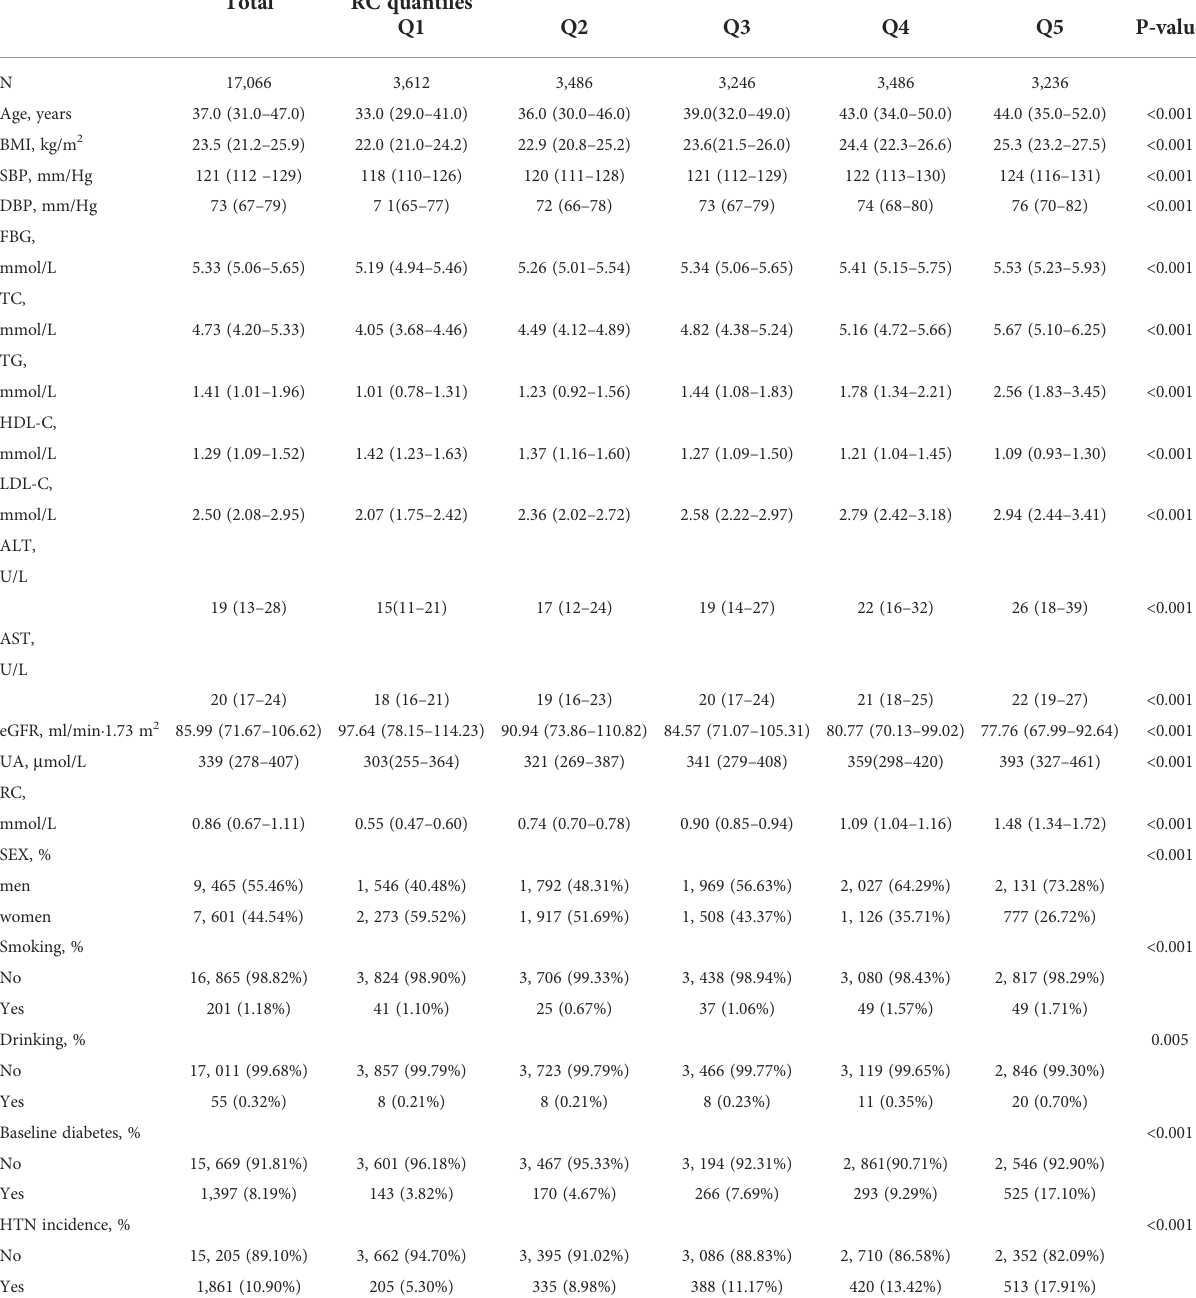
TABLE 1 Characteristics of the study population by RC